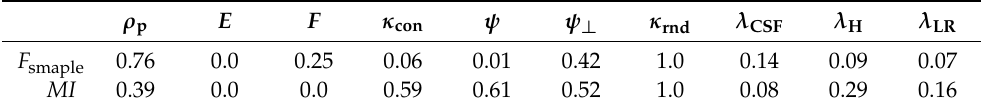
Table 6. Normalized results of a F-test and the mutual information for feature selection regarding the terminal settling velocity.